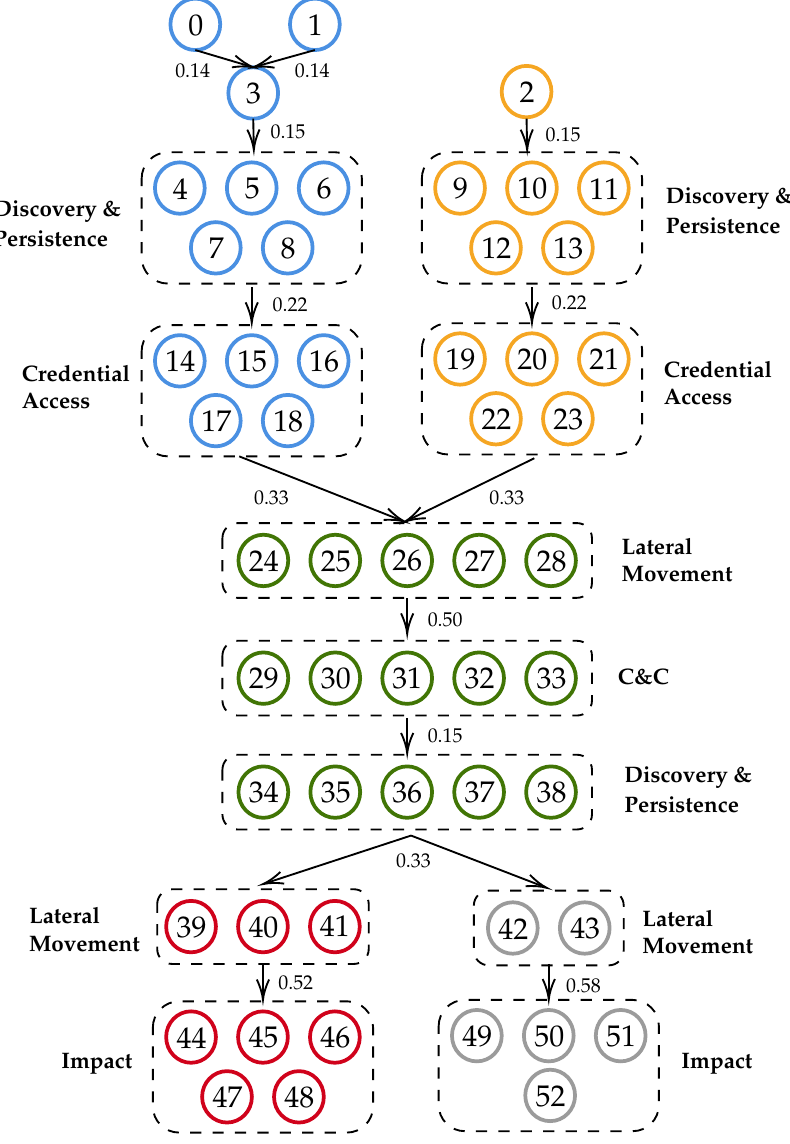
Figure 1. Use case graph utilizing nodes of Table